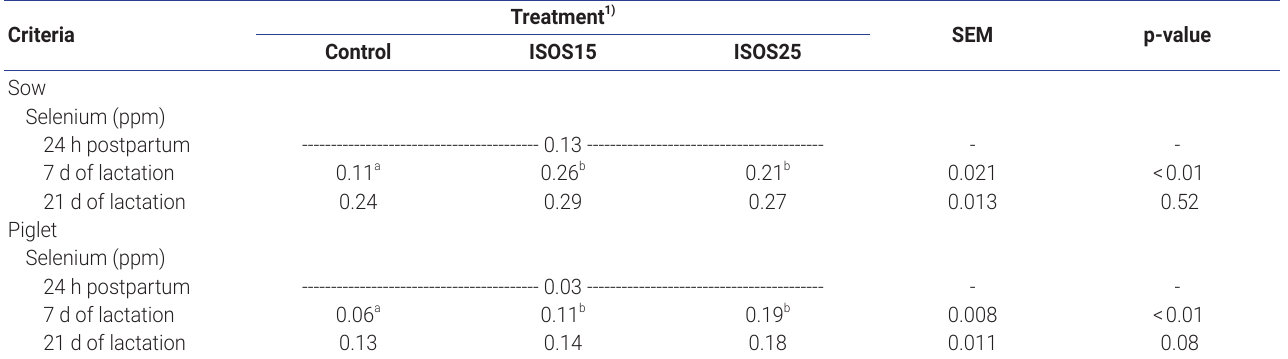
Table 5. Effects of supplemental selenium on the serum selenium concentration in sows and piglets Criteria